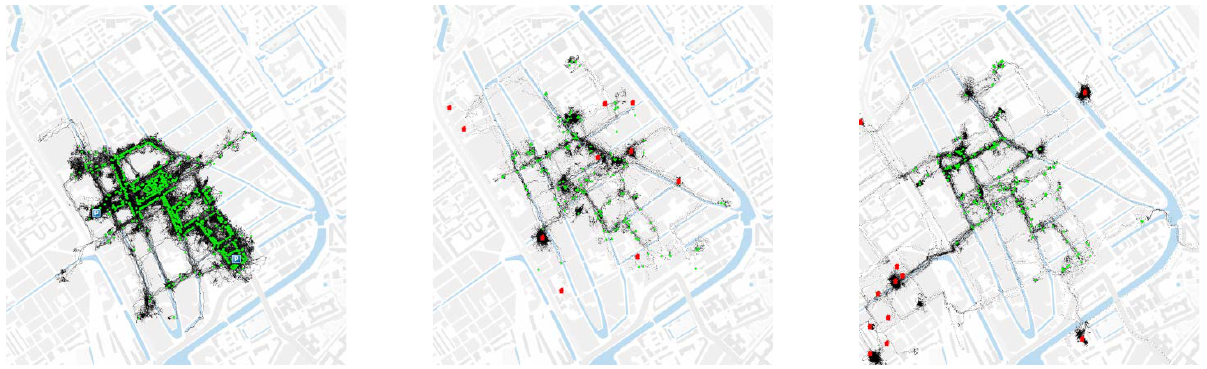
Figure 1. Tracking results of Tracking Delft: track and destinations. (left) visitors from parking garages, (middle) inhabitants of city centre, (right) inhabitants of surrounding